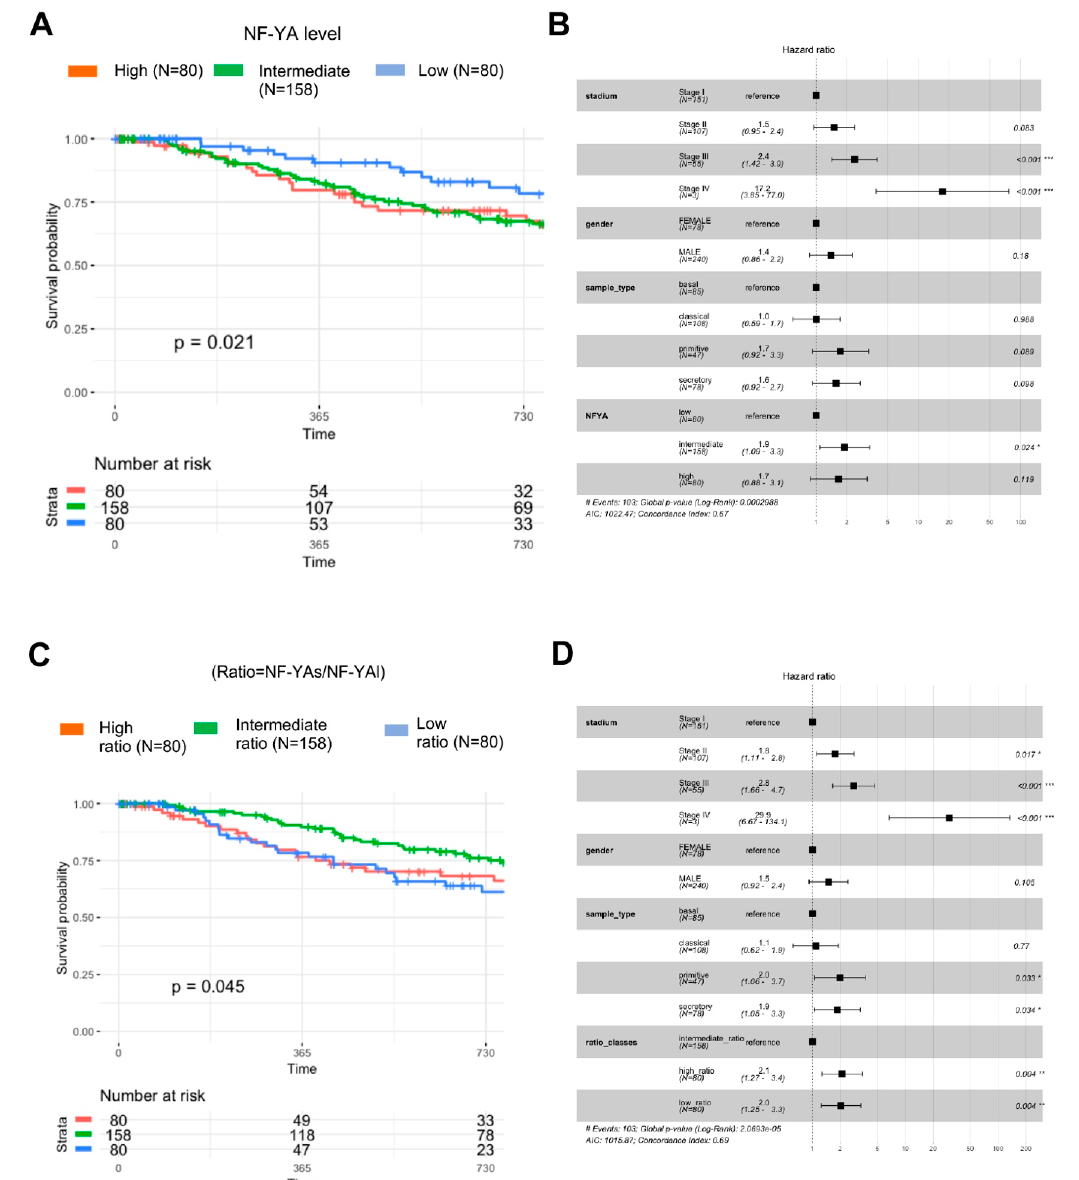
Figure 8. Clinical outcome of LUSC tumors with di ff erent NF-YAs / NF-YAl ratio. ( A ) Progression-free- interval curves of survival probability of the 318 LUSC tumors with available clinical data, stratified according to quartiles of global NF-YA levels (intermediate, high and low). ( B ) Hazard ratios of the three cohorts as above, according to Stage (I–IV), gender, sample type (basal set as reference) and global NF-YA levels. ( C ) Same as A, except that data were stratified according to quartiles of NF-YAs / NF-YAl ratios (intermediate, high and low). ( D ) Hazard ratios of the sample cohorts partitioned according to Stage (I–IV), gender, sample type (basal set as reference) and NF-YAs / NF-YAl ratios. P values are calculated using a Cox proportional hazards regression analysis (See Materials and Methods). * p value < 0.05, ** p value < 0.01, *** p value < 0.0001.